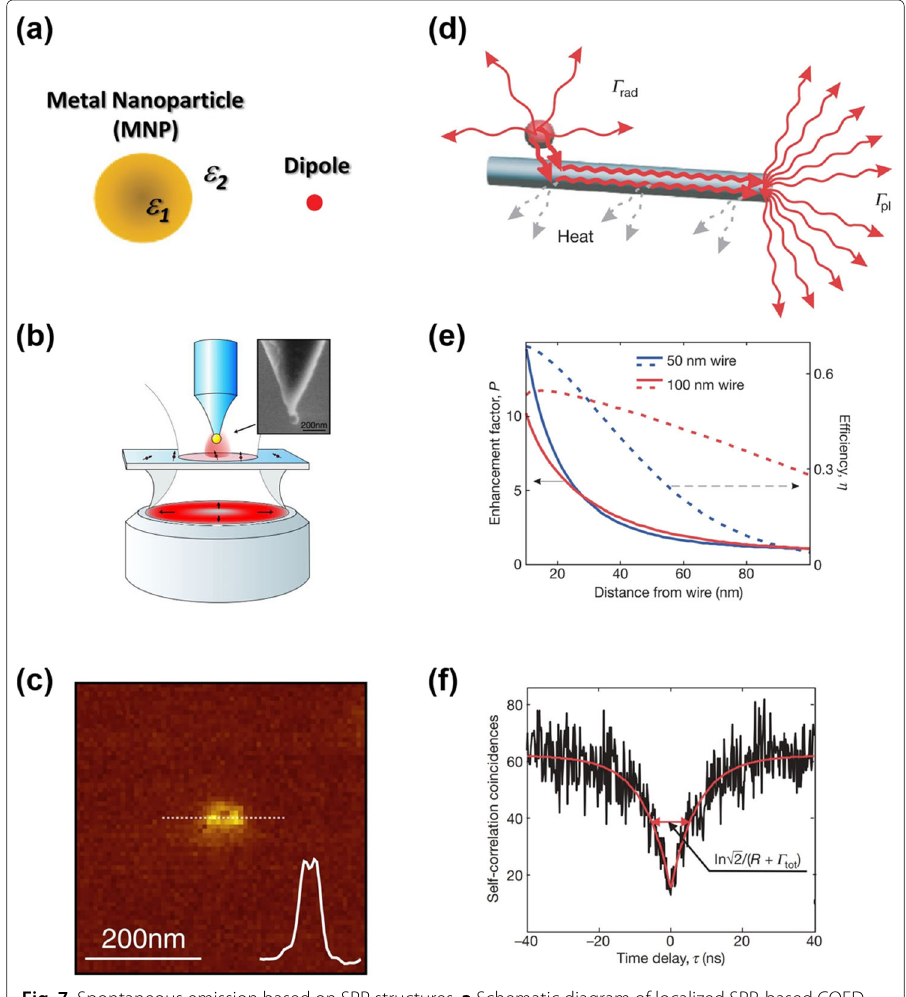
Fig. 7 Spontaneous emission based on SPP structures. a Schematic diagram of localized SPP-based CQED system [222]. b Sketch of the experimental arrangement with SEM image of a gold nanoparticle [223]. c Fluorescence image of particle-emitter interaction with dip in the center indicating quenching [223]. d Schematic diagram of SPP-based CQED system [224]. e Purcell factor (solid curve) and efficiency of emission into surface plasmons (dashed curve) with different size of wires [224]. f Second-order correlation function g ( 2 ) (τ) of quantum dot fluorescence using SPP-CQED system